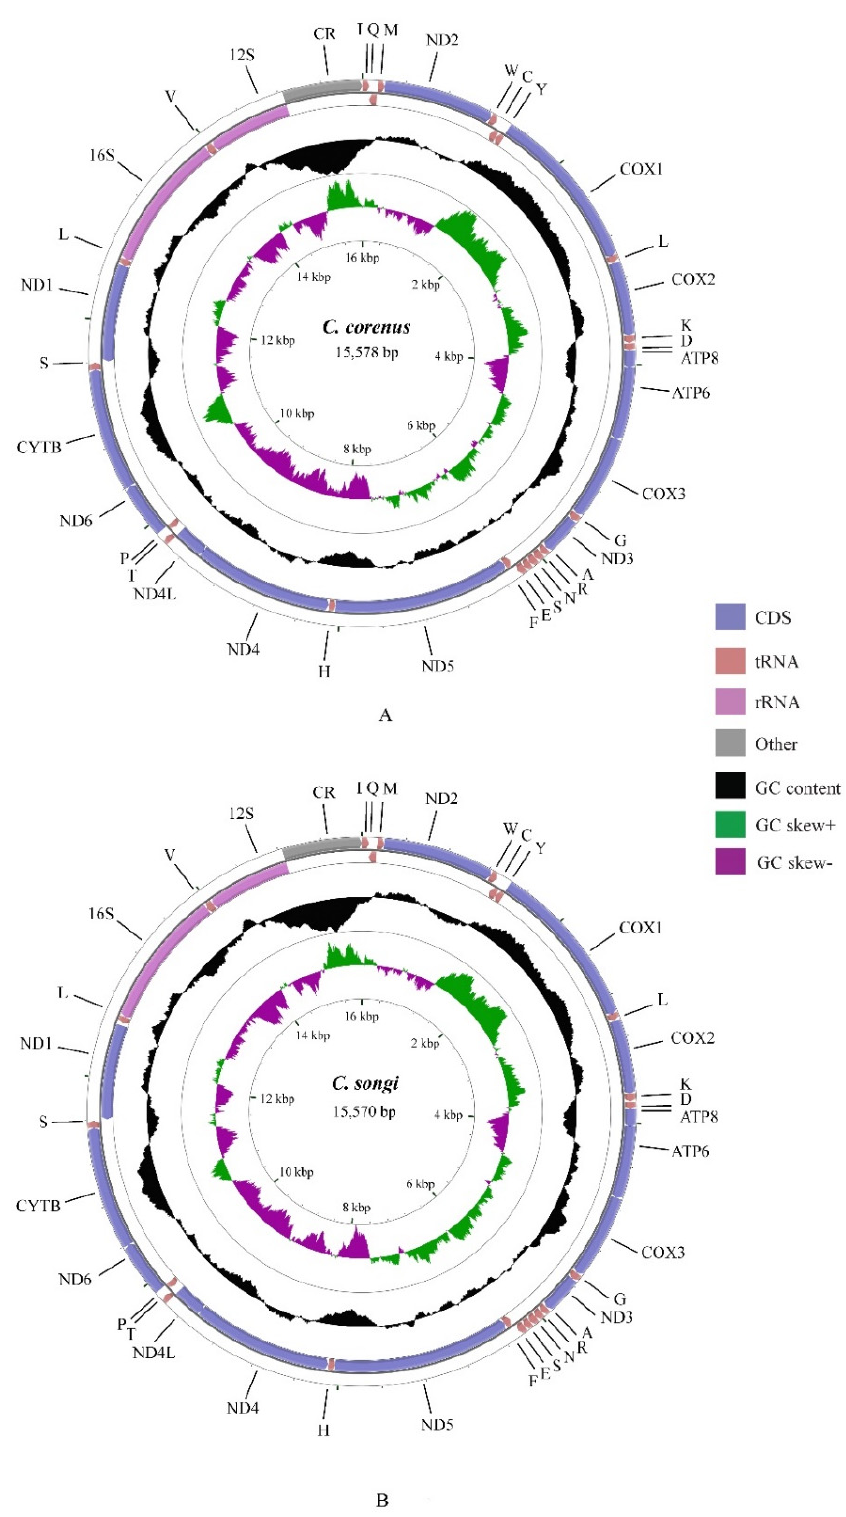
Figure 1. Mitochondrial genome maps of C. coreanus ( A ) and C. songi ( B ). The first circle shows the gene map (PCGs, rRNAs, tRNAs and the AT-rich region) and the genes outside the map are coded on the majority strand (J-strand) whereas the genes inside the map are coded on the minority strand (N-strand). The second circle shows the GC content and the third shows the GC skew. GC content and GC skew are plotted as the deviation from the average value of the entire sequence.